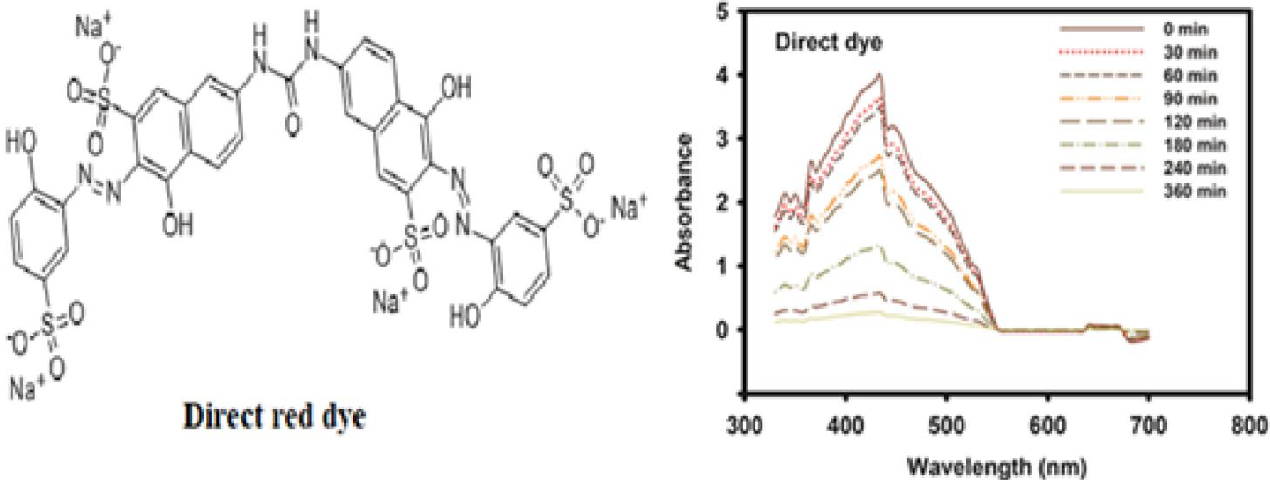
Figure 3. Photo-reduction of Direct Red 83 dye with Ca-ALG/MgO/Ag nanocomposite beads sample under visible light: (catalyst weight 0.3 g, NaBH 4 3 mL, and dye concentration 100 mg/L at λ = 460 nm).